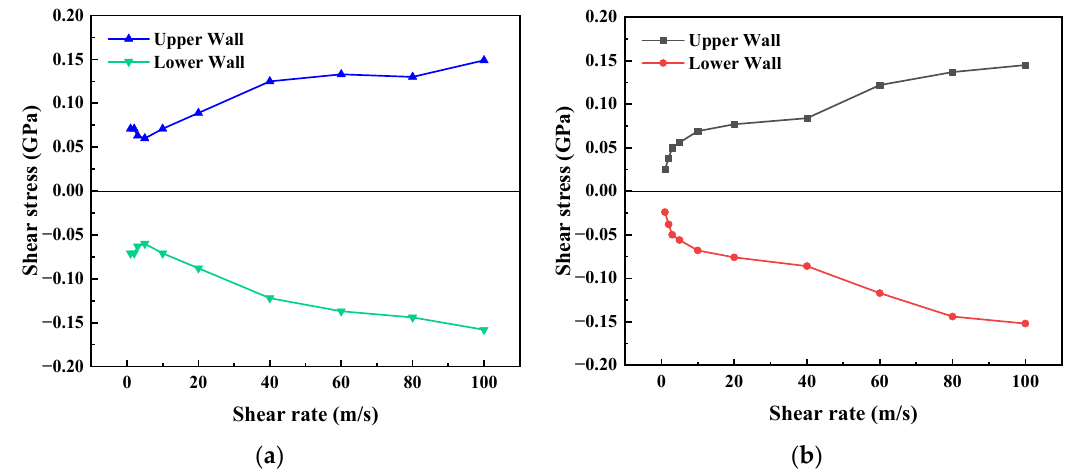
Figure 7. Effect of shear rate on the stress of the ( a ) base asphalt lubricating film at simulation temperature of 443 K; ( b ) warm mix asphalt lubricating film at simulation temperature of 393 K.